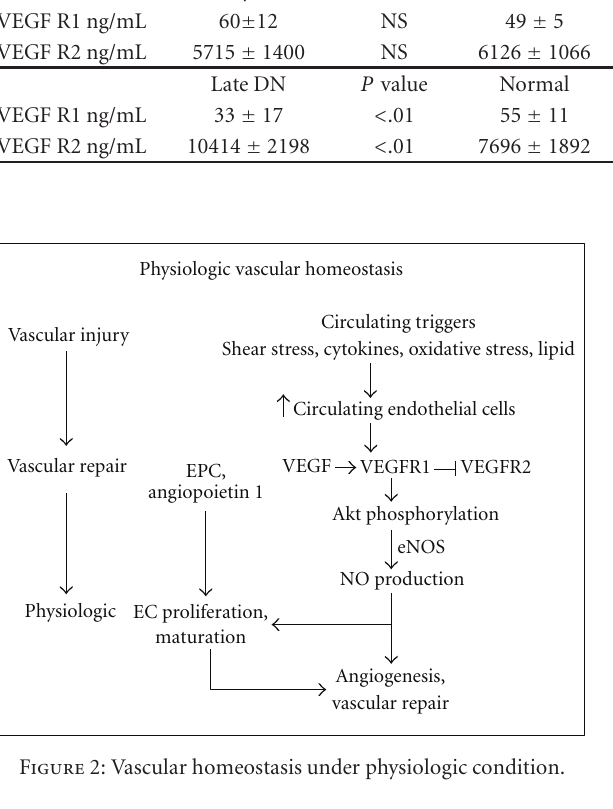
in an adequate vascular repair and normal angiogenesis (Figure